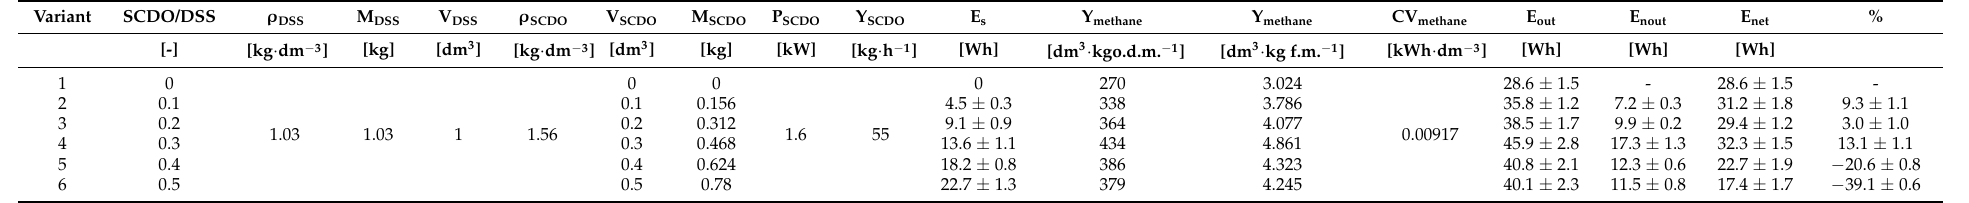
Figure 6. Energy values obtained upon MF of DSS after LTC-SCDO. Table 3. Energetic analysis of methane fermentation (MF) of DSS after